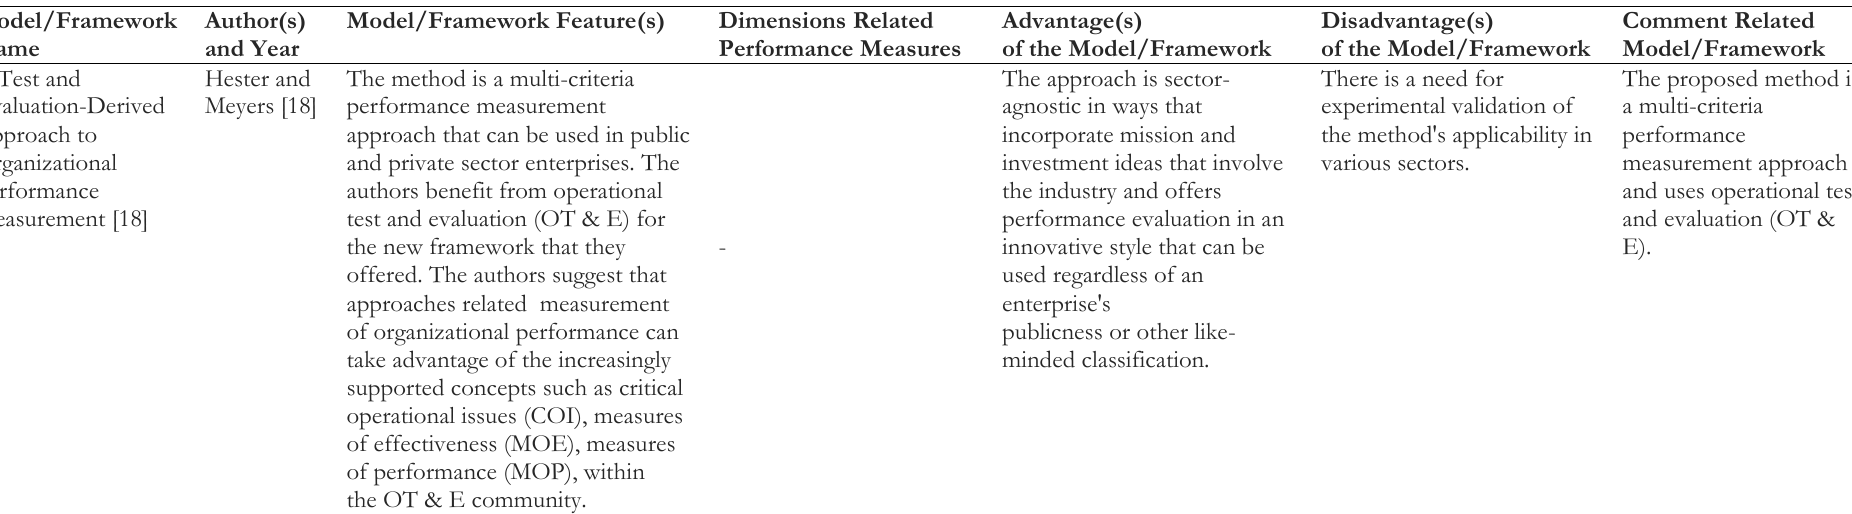
Table 17. Organizational performance measurement models developed in Industry 4.0.